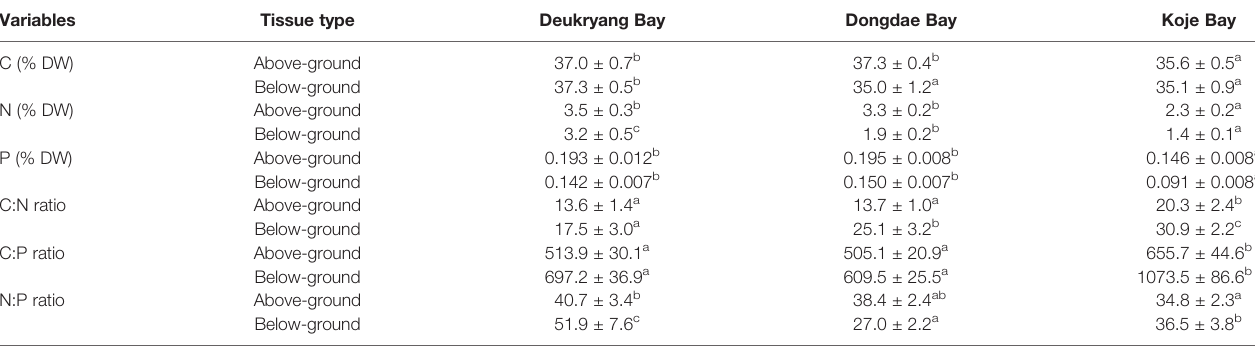
TABLE 4 | Carbon (C), nitrogen (N), and phosphorous (P) contents, as well as their elemental ratios, in above- and below-ground tissues of Zostera marina in Deukryang Bay, Dongdae Bay, and Koje Bay on the southern coast of Korea. Variables Tissue